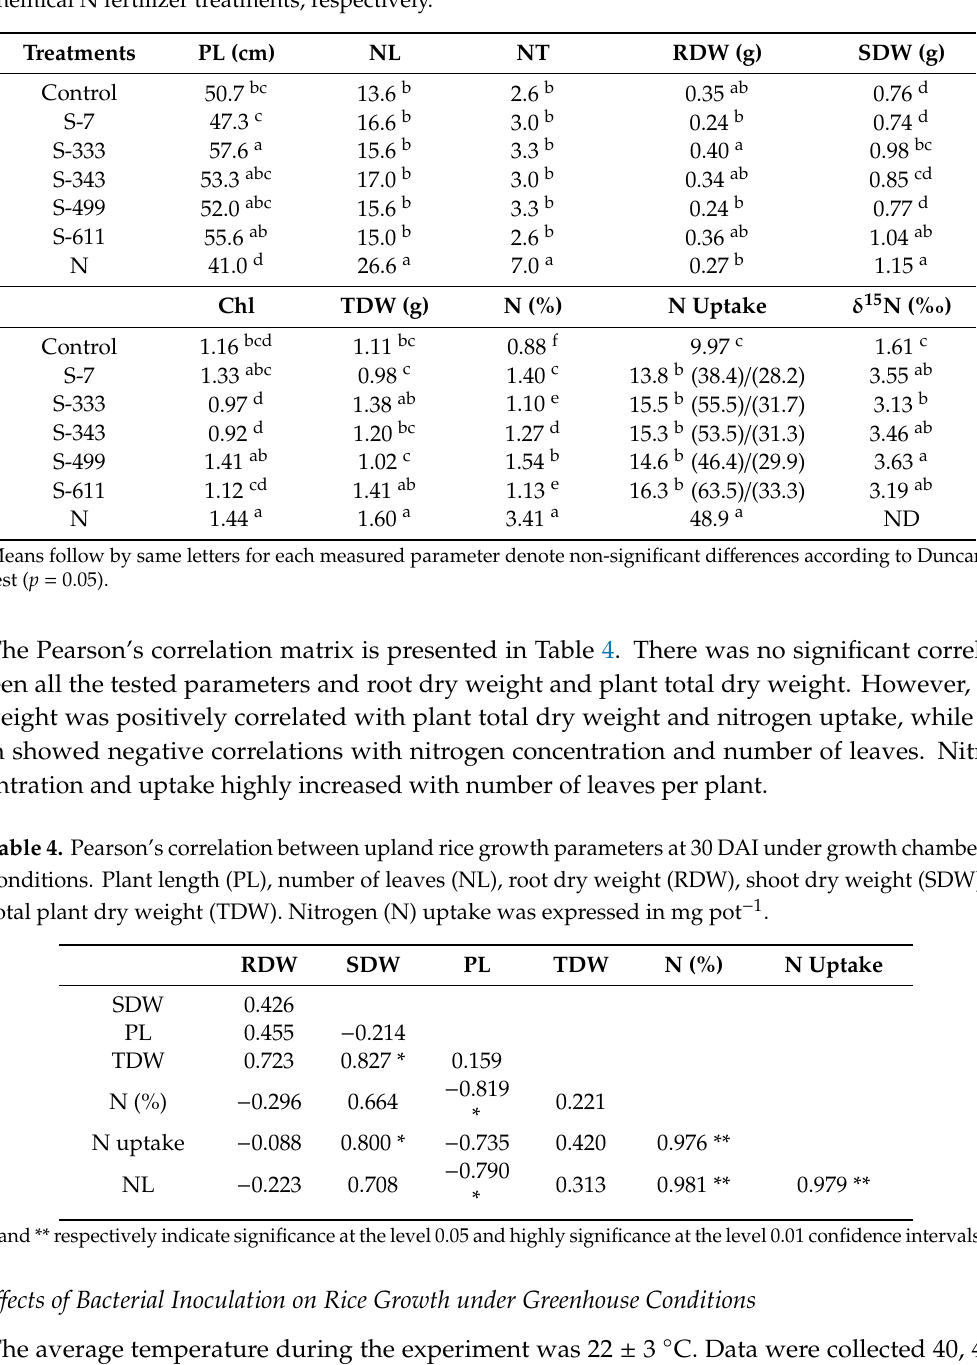
Table 3. Response of upland rice on bacterial inoculation under growth chamber conditions. Plant length (PL), number of leaves (NL), number of tillers (NT), root dry weight (RDW), shoot dry weight (SDW), total plant dry weight (TDW) and total chlorophyll content (Chl, mg g − 1 fresh weight). Nitrogen (N) uptake is expressed in mg pot − 1 . ND denotes not determined values. Values (in percentage) in parenthesis and bold represent the bacterial contribution to N uptake in comparison to the control and chemical N fertilizer treatments, respectively. PL (cm) NL NT